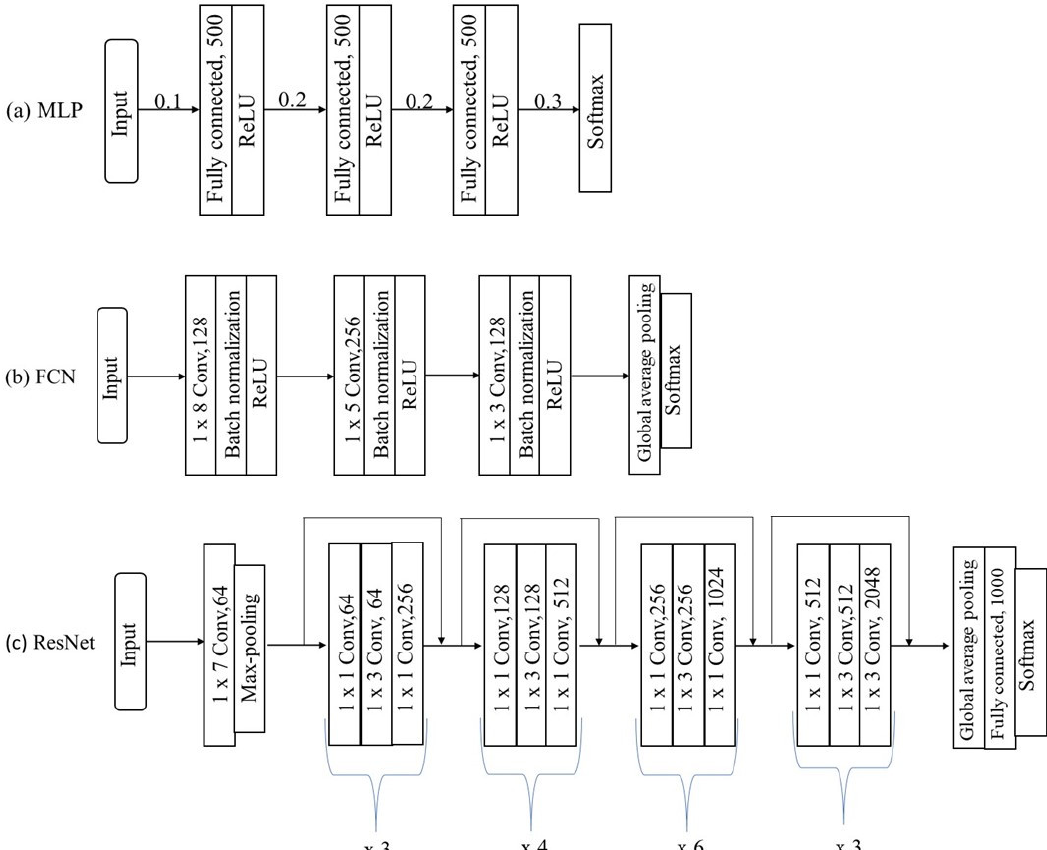
Figure 4. Data augmentation: the original waveform [] was sectioned into 0.06 s   [] seg- ments to increase the amount of data for 1D CNN training, validating, and testing.